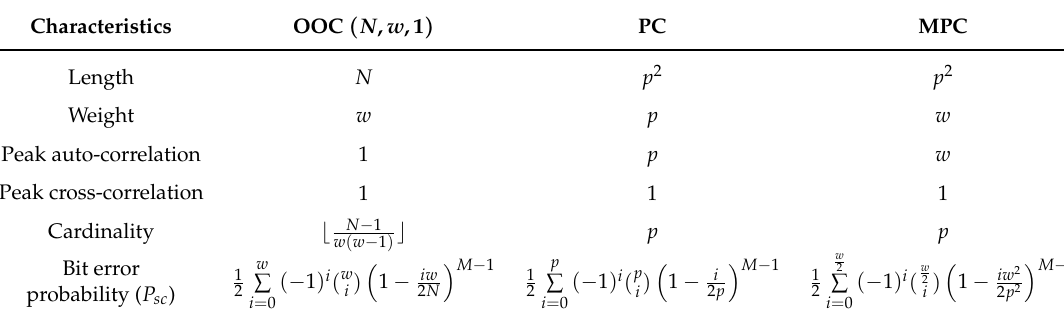
Table 8. Performance comparison of optical spreading